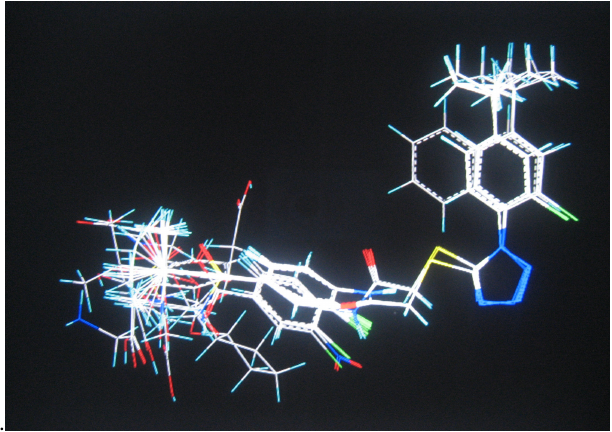
Figure 2. Alignment of all molecules used for CoMFA